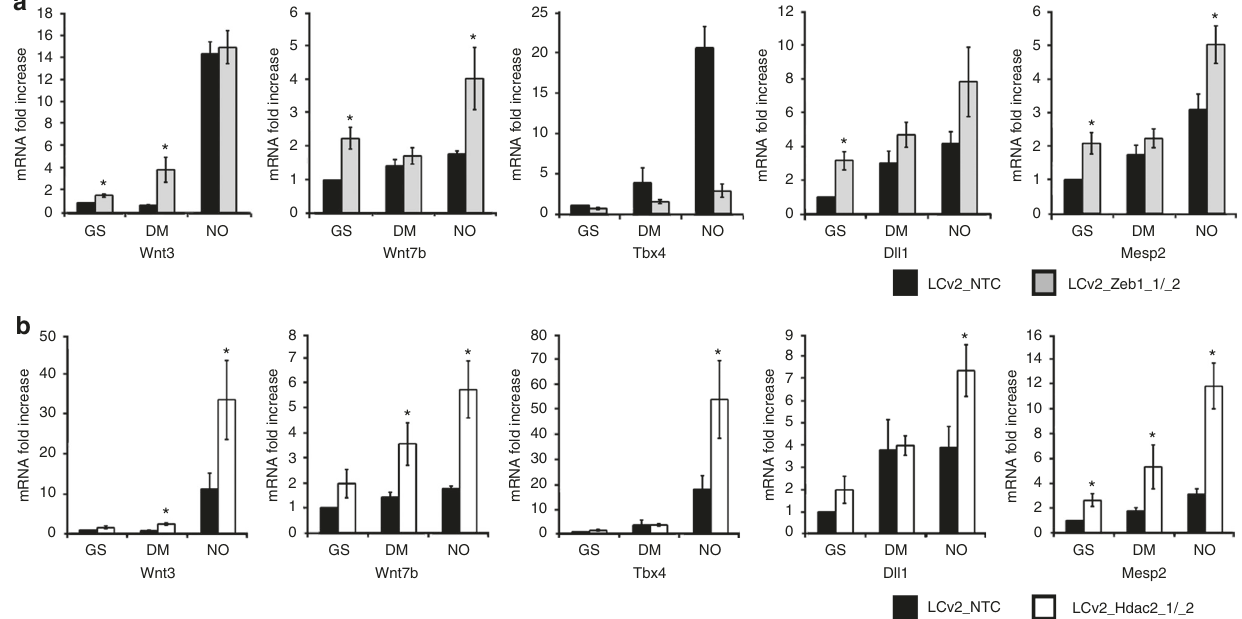
Fig. 4 Evaluation of mesendodermal transcripts in mESC engineered by CRISPR-Cas9. a qRT-PCR analysis of mRNA expression relative to Wnt3, Wnt7b, Tbx4, Dll1, and Mesp2 transcripts in mESC cultured for 24 h in GS, DM, and NO prior (control vector LCv2_NTC; black bar) and after CRISPR/Cas9 inactivation of Zeb1 (LCv2_Zeb1_1/_2; gray bars). Data are shown as the mean of three independent experiments for each CRISPR/Cas9 vector ± s.e.m. represented as fold increase compared to control mESC after subtraction of the housekeeping gene p0 signal (* p < 0.05 LCv2_Zeb1_1/_2 vs. LCv2_NTC). b qRT-PCR analysis of mRNA expression relative to Wnt3, Wnt7b, Tbx4, Dll1, and Mesp2 transcripts in mESC cultured for 24 h in GS, DM, and NO prior (control vector LCv2_NTC; black bar) and after CRISPR/Cas9 inactivation of Hdac2 (LCv2_Hdac2_1/_2; white bars). Data are shown as the mean of